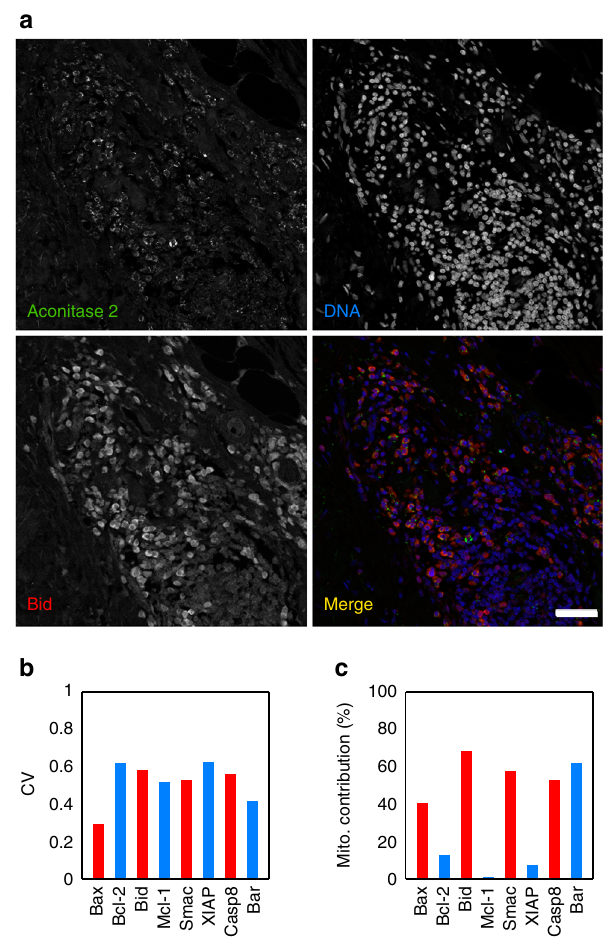
Fig. 7 Colon cancer cells show variability in apoptotic proteins and mitochondria. a Colon cancer section stained with Aconitase 2, Bid and DAPI. This image illustrates the variability in expression of Bid and Aconitase 2. Scale bar: 50 μ m. b Coef fi cient of variation (CV) of several proteins involved in the apoptosis pathway. c Mitochondrial contribution to variability of the apoptotic proteins. Data are representative of four independent biopsies. Statistical quantities were obtained from ensembles of 500 – 1000 cells for each protein